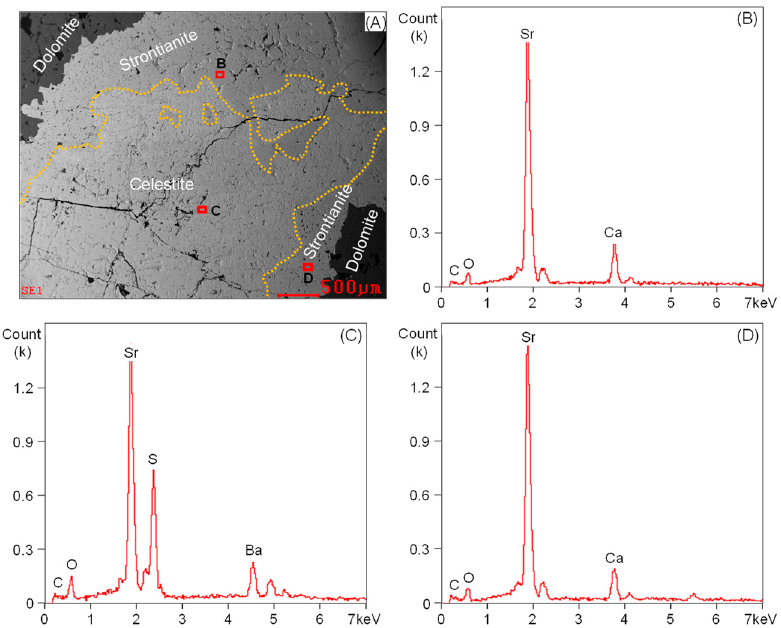
Figure 5. Back scattered electron images ( A ) and qualitative analysis of minerals of three points ( B – D ) in ( A ) using energy-dispersive spectrometry, 6640.15 m, P 3 c , YB29.